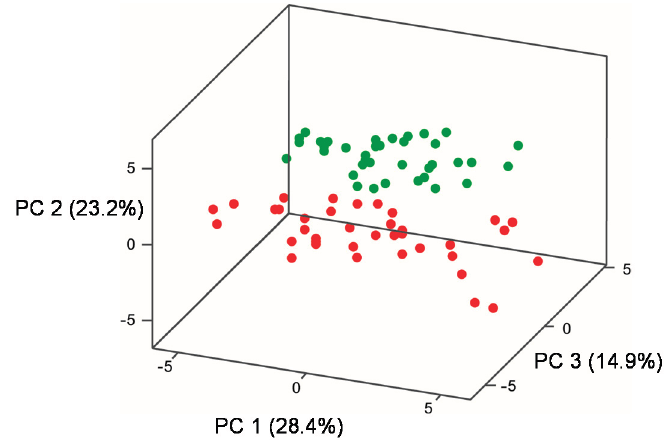
Figure 3. Principal component analysis (PC 1, PC 2, PC 3) of the mean concentration of 25 volatile compounds (nine higher alcohols, seven ethyl esters, five acetate esters, two aldehydes, one acid, one acetal) in Pinot noir, fermented using five industrial strains, three individual- and four mixed-Burgundian S. cerevisiae isolates in triplicate, at 22 °C (green) and 27 °C